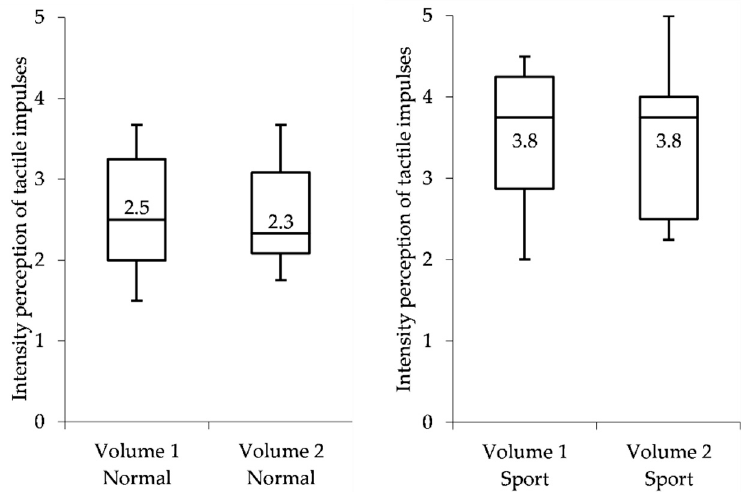
Figure 4. Intensity perception of tactile impulses in the suspension mode normal ( Left ) and in the suspension mode sport ( Right ) for two volumes, rating scale ranging from 0 “not perceptible” to 5 “very strongly perceptible”. Table 3. Statistical evaluation: Influence of audible impulses on the perception of tactile impulses (N: Normal, S: Sport).